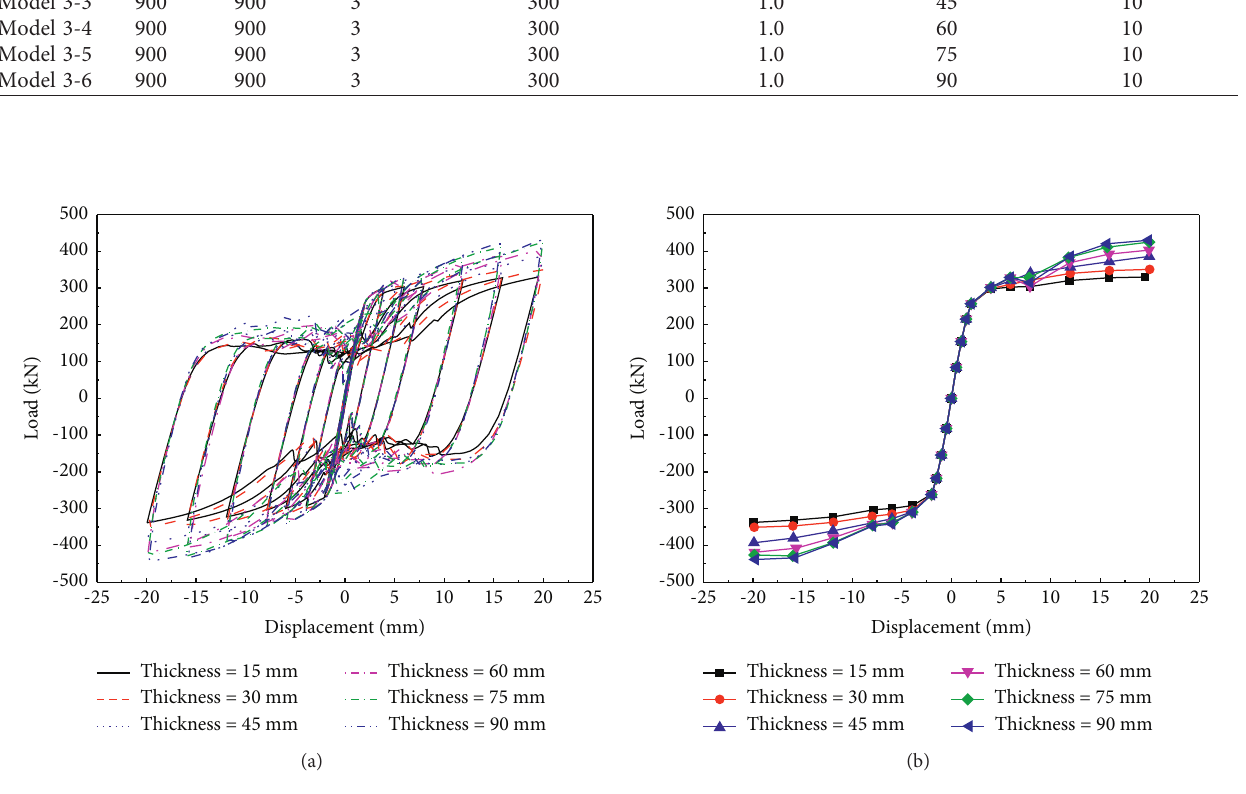
Figure 24: The effect of concrete slab thickness. (a) Hysteretic curves. (b) Skeleton curves.